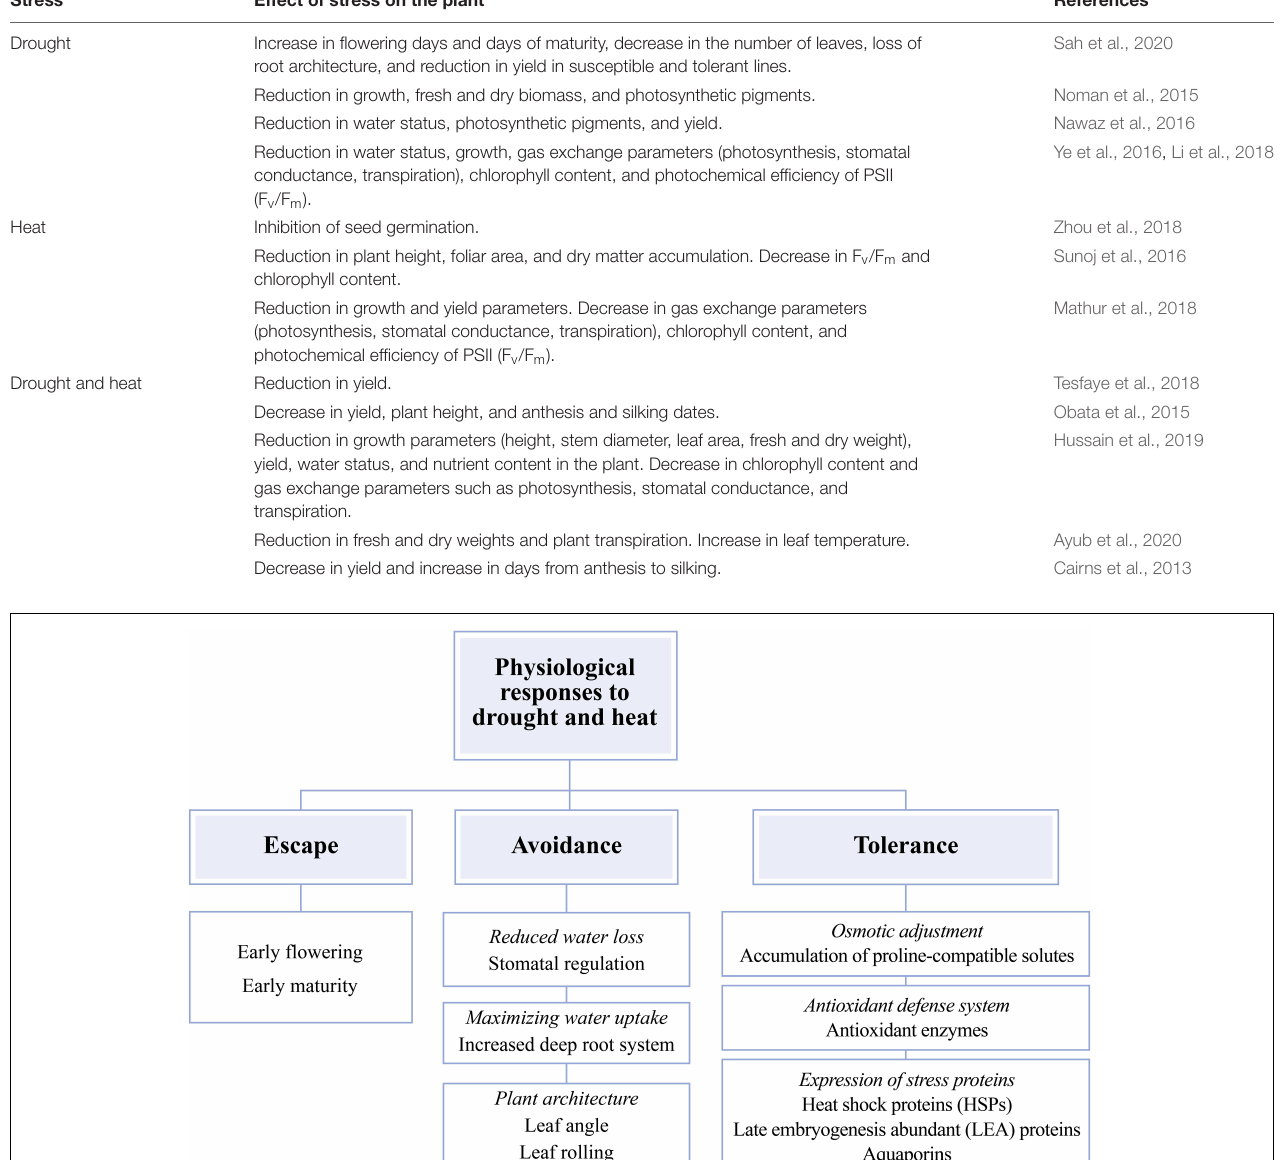
TABLE 2 | Summary of the impact of heat and drought stress (individual or in combination) on the physiological responses of maize ( Zea mays L.) plants. Stress